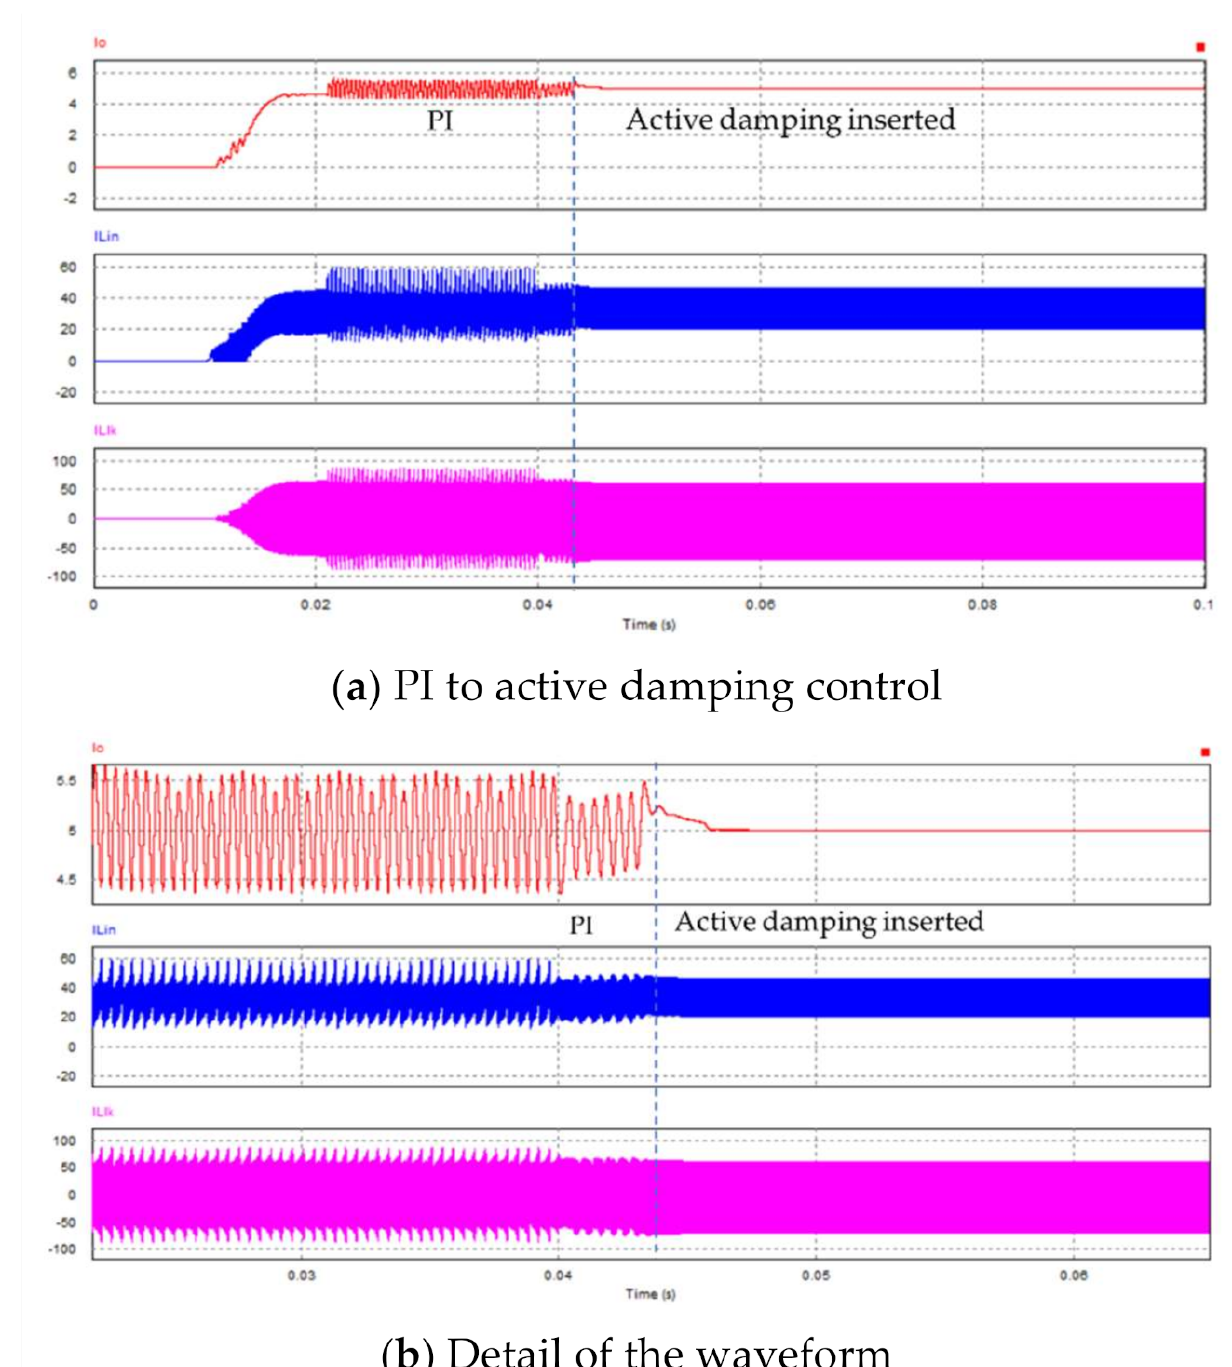
Figure 23. Simulation result of inserting active damping ( I o = 5 A